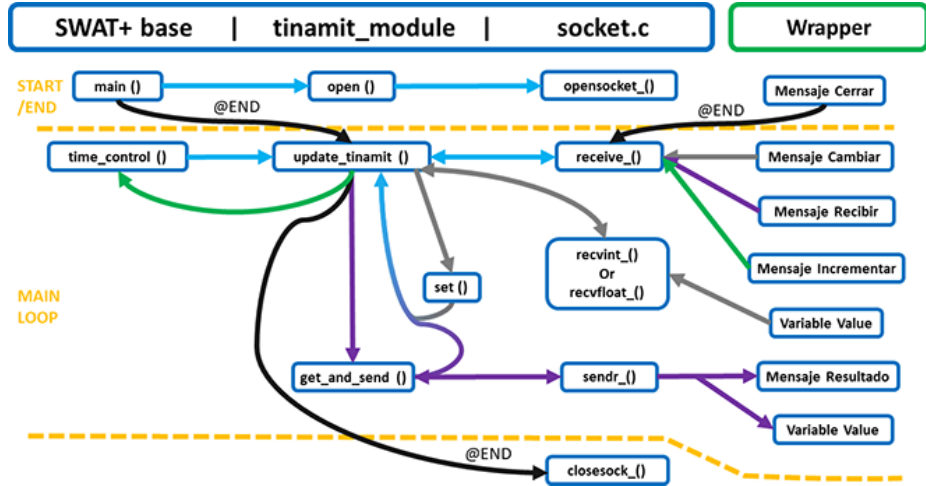
Figure 2. Graphic representation of the expected SWAT + model behavior and communication with the wrapper during coupled model execution. The set loop is shown in gray, the “get_and_send” loop is shown in purple, the incrementation pathway, which informs the model engine to run for a specified number of time steps, is shown in green, and the closing sequence is in black. All other pathways of information and function calls, including those used for multiple abovementioned pathways, are shown in